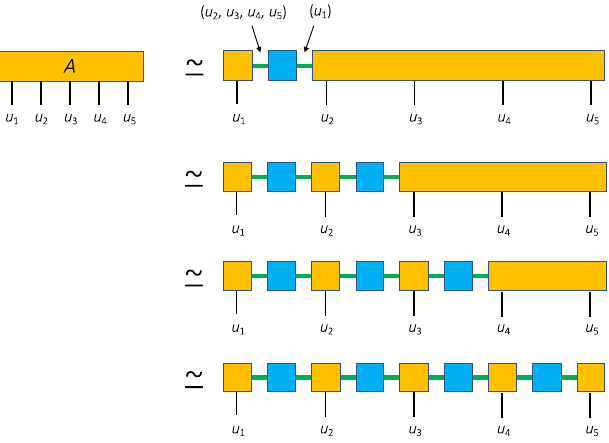
FIG. 3. Step by step representation of a simple algorithm to factorize a multidimensional tensor into a tensor train. The blue squares represent the inverses of the pivot matrices. Summation is implicit over the indices connecting two tensors (green